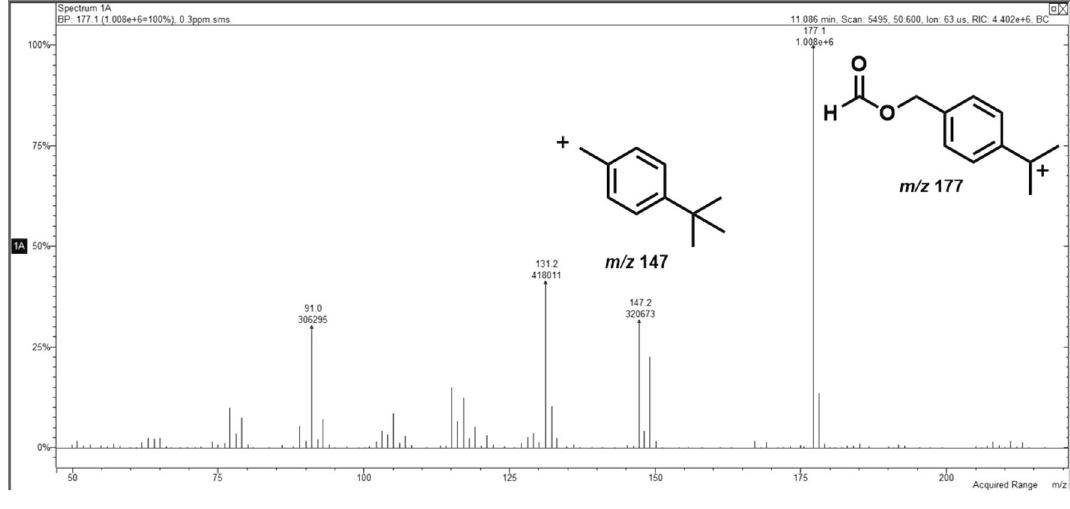
Fig. 2 The EI mass spectrum of 4- t -butylbenzyl formate (MW 192)